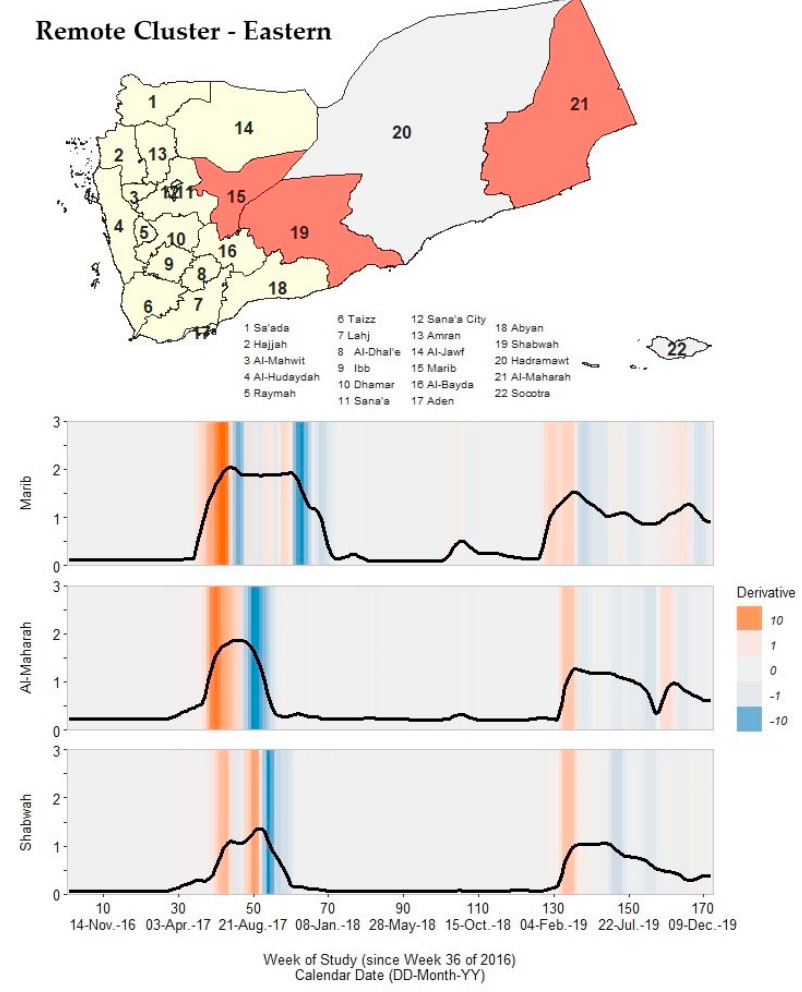
Figure 9. A map of Yemen with a shaded outbreak cluster including Marib, Al-Maharah, and Shabwah, and a stacked time series plot and heatmap for each governorate’s outbreak signature. Top panel: the governorate-level map indicates governorates within the cluster in orange, remaining governorates within our study in yellow, and excluded governorates in grey (the Hadramaut and Socotra island governorate). Bottom panel: stacked time series plots for each governorate within the cluster. All plots show log10-transformed smoothed rates produced using Kolmogorov–Zurbenko adaptive filters from Week 36 (4–11 September) of 2016 through Week 52 (23–29 December) of 2019. Smoothed rates (laboratory-confirmed cholera cases per 100,000 persons) were estimated using the best performing smoother. Backgrounds for each plot are heatmaps of trivial derivative values, ranging from − 10 (dark blue) to +10 (dark orange) with values near zero in grey. Time series plots have a common horizontal axis of time reported in weeks since Week 36 of 2016 (defined as study Week 0). All rates and trivial derivates were calculated for the 172 weeks of time series. Data used to develop this visualization are reported in Table 1 and Supplementary Excel Table S5.